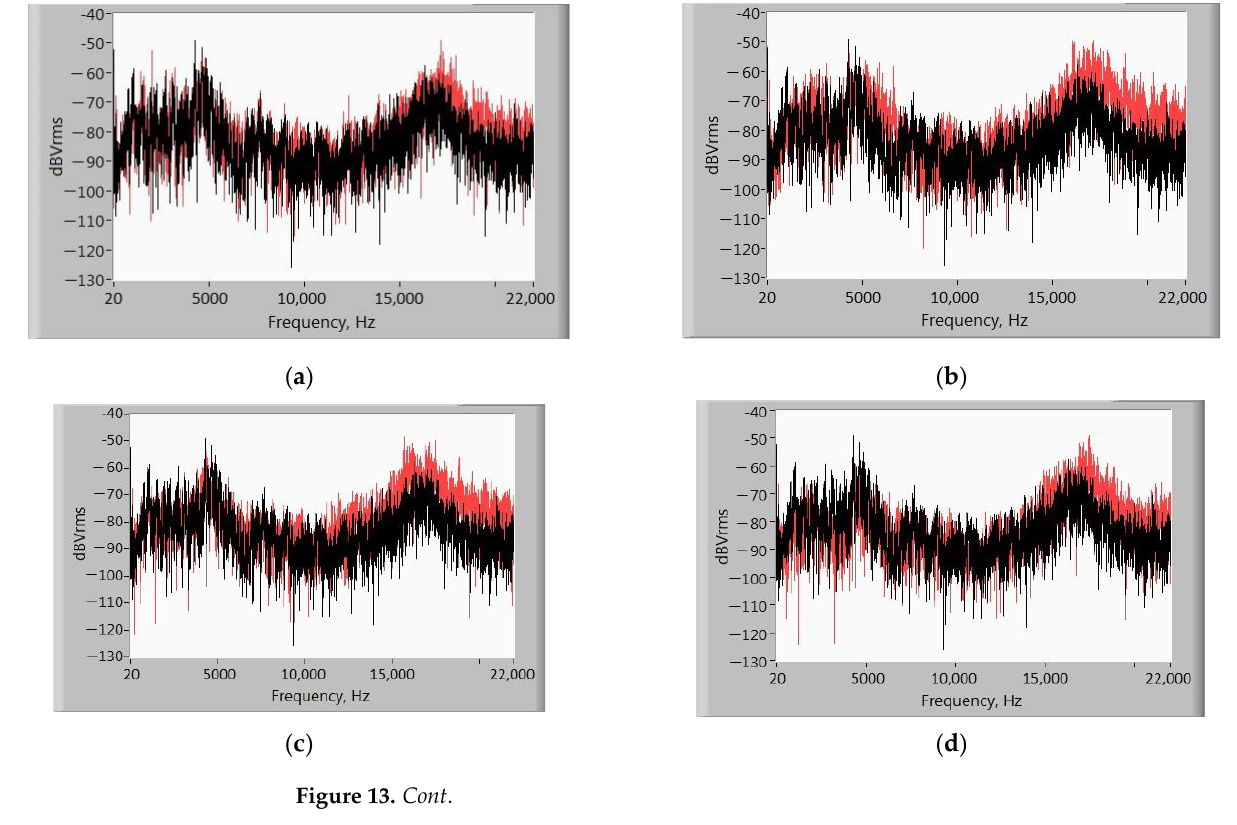
( h ) Figure 13. Spectra of acoustic signals of the pipeline at a pressure of 2 bar (the spectrum of a defect – free pipeline is indicated in black; the spectrum of a pipeline with a leak is indicated in red): ( a ) for